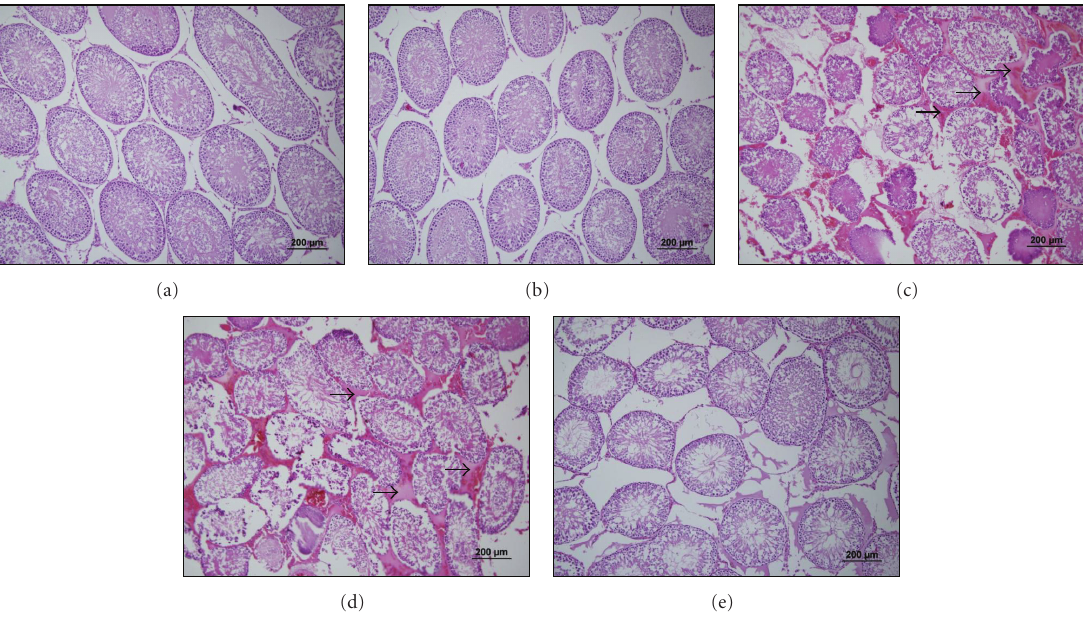
Figure 4: Representative photomicrographs of H-E stained sections of the testis tissue. (a), (b), (c), (d) and (e) show sections of control, sham, ischemia, I/R (2h torsion 720 ◦ in a clockwise direction and 2 h detorsion of the testis) and I/R + LA (100 mg/kg ip, 30 minutes prior to detorsion) groups, respectively. In the I and I/R groups, seminiferous tubular disorganization, degenerative changes and loss of maturation in the germinal cells, interstitial edema, and interstitial hemorrhage were observed. Arrows indicate interstitial edema and hemorrhage.